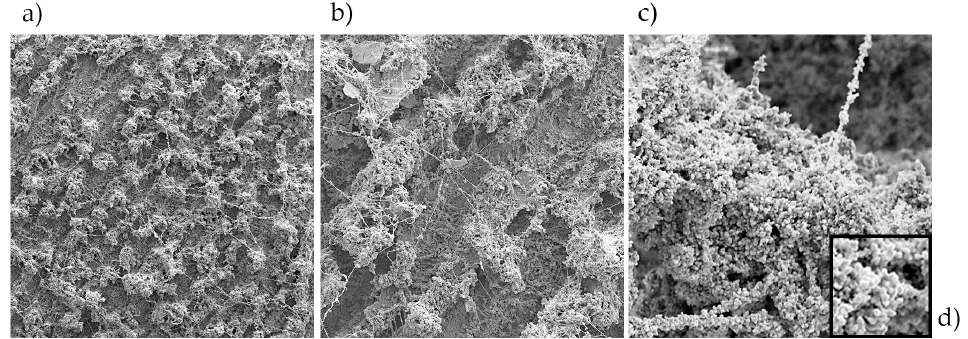
Table 5. Surface roughness ( R a ) and drop bounces for the Nd:YAG laser ablated PTFE coatings processed at the optimum ranges of fluence and velocity. Comparison with the optimum results obtained by other methods.